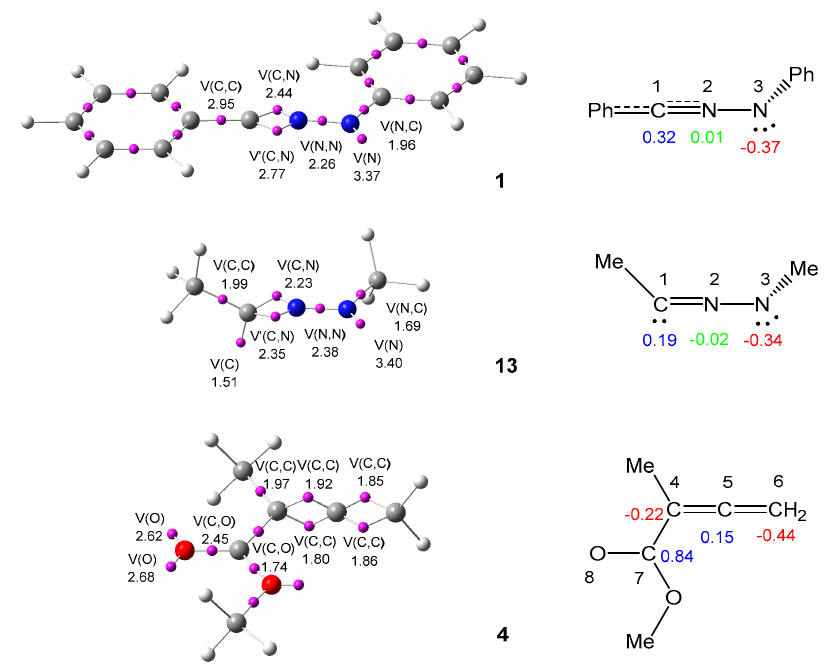
Figure 1. MPWB1K / 6-311G(d) electron localisation function (ELF) basin attractor positions, together with the valence basin populations, and the proposed Lewis-like structures, together with the natural atomic charges, for NIs 1 and 13 , and allenoate 4 . Negative charges are coloured in red, negligible charges are coloured in green and positive charges in blue. ELF valence basin populations and natural atomic charges are given in average number of electrons, e.